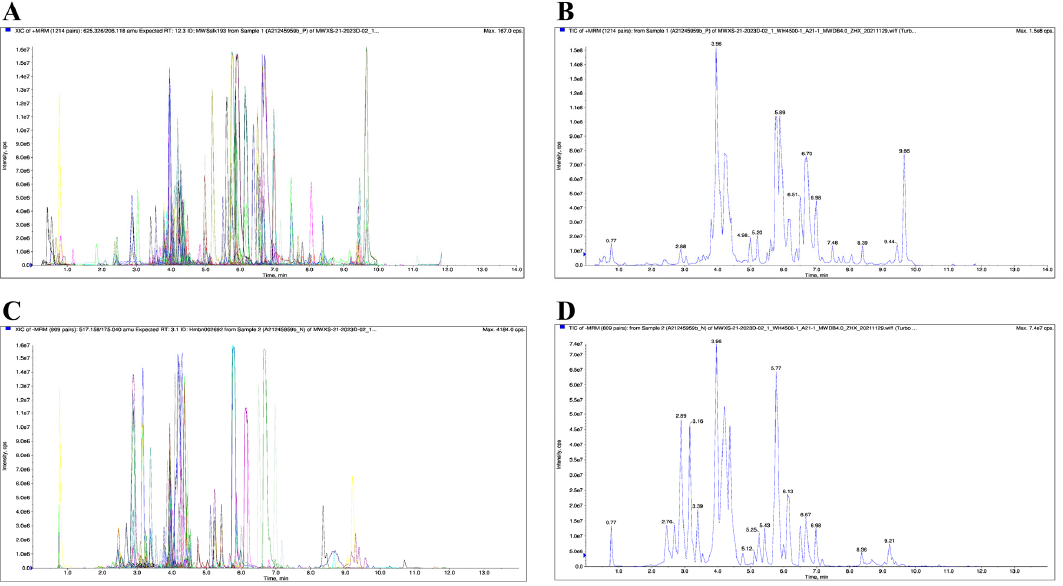
Figure 1. Chemical constituents of AaEA were analyzed by LC-MS. Positive ion chromatogram of AaEA ( A , B ) and negative ion chromatogram of AaEA ( C , D ).